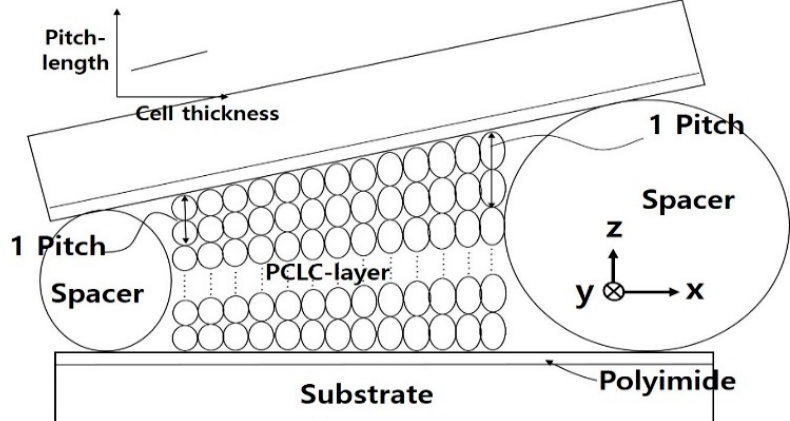
Figure 2. Schematic diagram of the wedge PCLC cell with continuous pitch gradient.